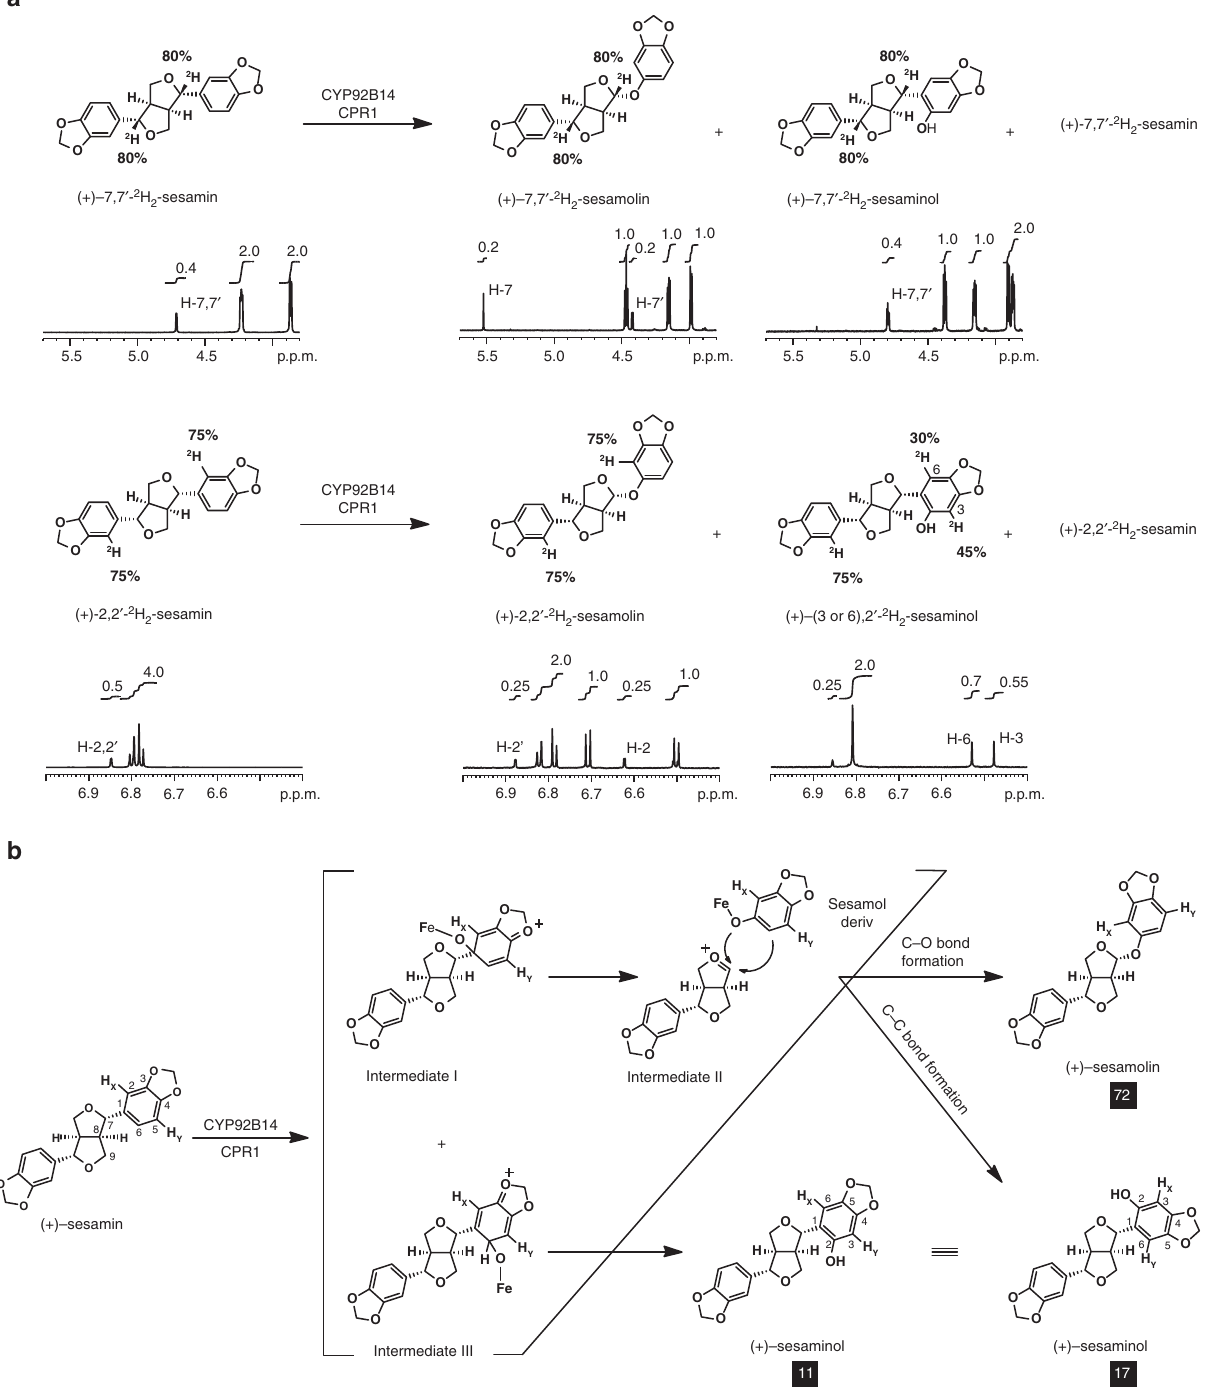
Fig. 5 CYP92B14 generates (+)-sesamolin and (+)-sesaminol from (+)-sesamin through multiple oxygenation schemes. a Enzyme assays using deuterated (+)-sesamin revealed the sites of initial oxidation by CYP92B14. No differences in the positions and deuterium-labeling content in (+) − 7,7 ′ - 2 H 2 -sesamin and (+)-2,2 ′ - 2 H 2 -sesamin were observed between before and after the reaction. Values (%) represent deuterium-labeling content calculated from NMR data. Note that the C3 and C6 positions of (+)-sesaminol correspond to the C5 and C2 positions of (+)-sesamin, respectively. b Proposed reaction pathways from (+)-sesamin to (+)-sesamolin and (+)-sesaminol. White letters indicate the molar ratio of respective enzyme assay products deduced from NMR analysis. The total amount of produced (+)-sesamolin and (+)-sesaminol was set as